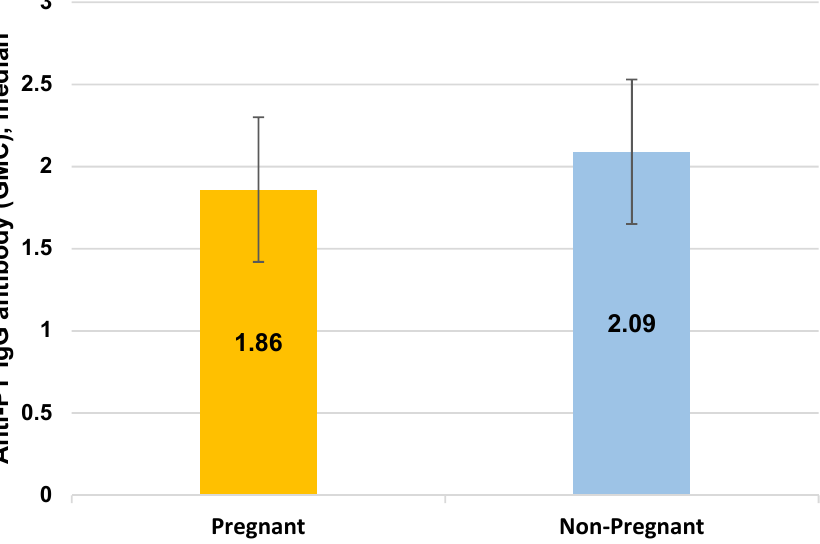
Figure 3. Anti-PT IgG antibody levels (GMC) in serum from pregnant ( n = 174) and non-pregnant ( n = 74) women. GMC = Geometric Mean Concentration.